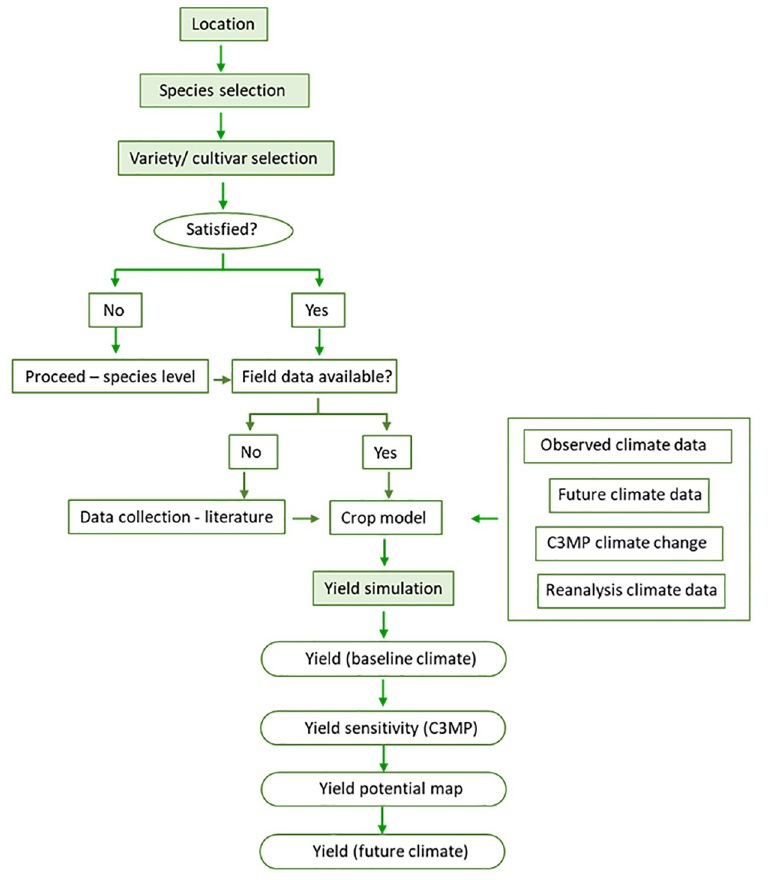
Fig 6. The process flow chart used to study the climate sensitivity of Proso millet.